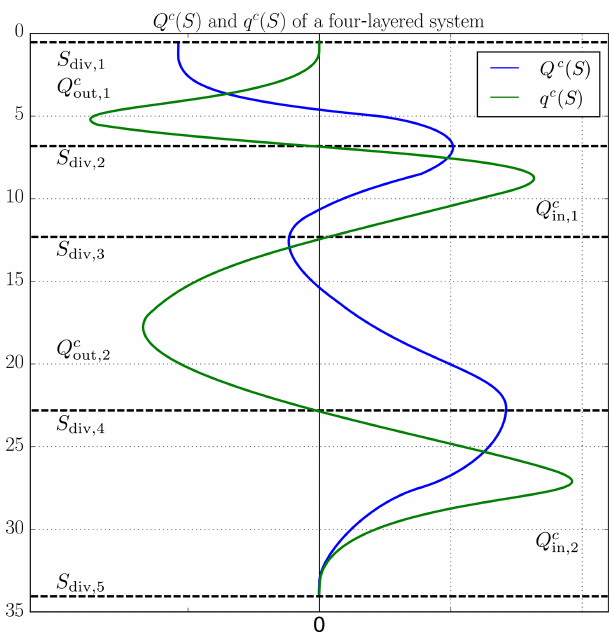
Figure 4. Sketch of hypothetical TEF profiles of a four-layered sys- tem with alternating inflows and outflows, Q c and Q c out ,m . The in ,m respective inflows and outflows are divided by the zero crossings of q c (S) (green), so-called dividing salinities, S div ,j (dashed, black), which correspond to the minima and maxima of Q c (S)